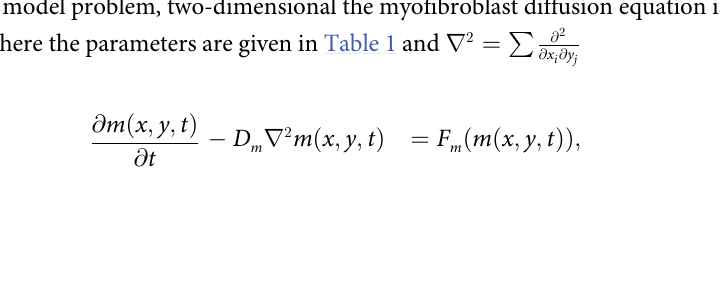
= 0.3 × 0.3 cm 2 and for a severe case of IPF, D